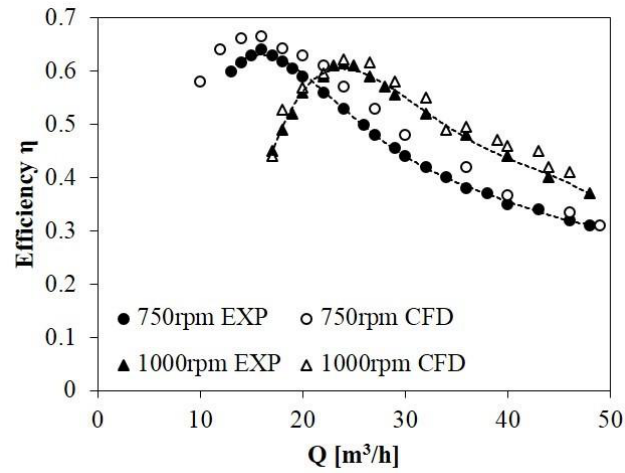
Figure 6. Comparison of five-blade turbine efficiency for computational fluid dynamics (CFD) and experimental results [26].